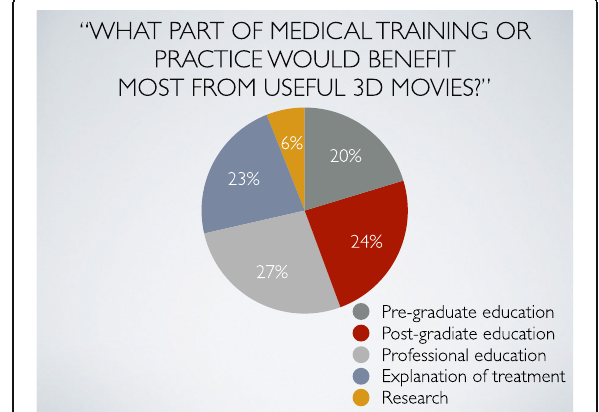
Fig. 6 Result 5. The answers about beneficial parts of medical